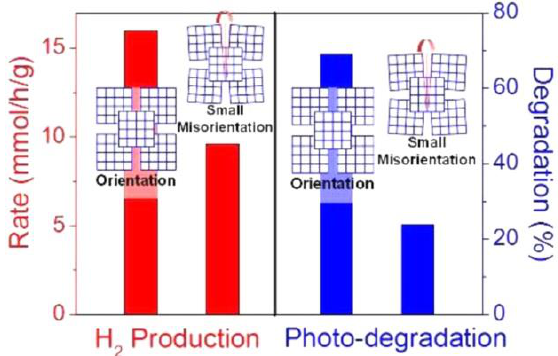
Figure 16. Rates comparison of phenol photodegradation and H 2 production upon TiO 2 mesocrystals built from well-ordered (red column) and less-ordered (blue column) orientation of nanocrystal subunits. Reprinted with permission from [184]. Copyright American Chemical Society, 2015.